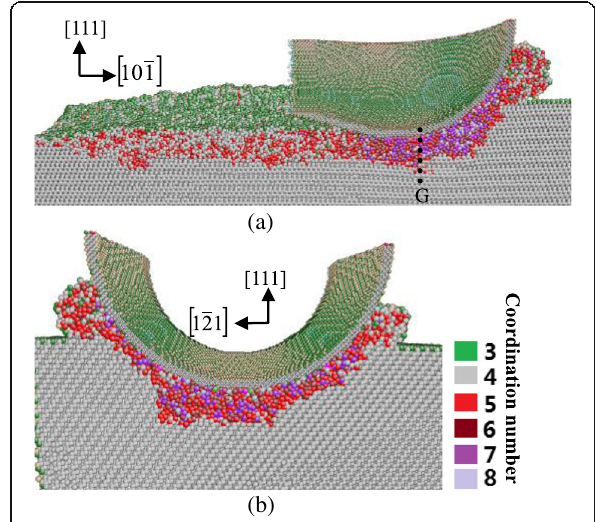
Fig. 11 Cross-sectional views of the subsurface deformation when